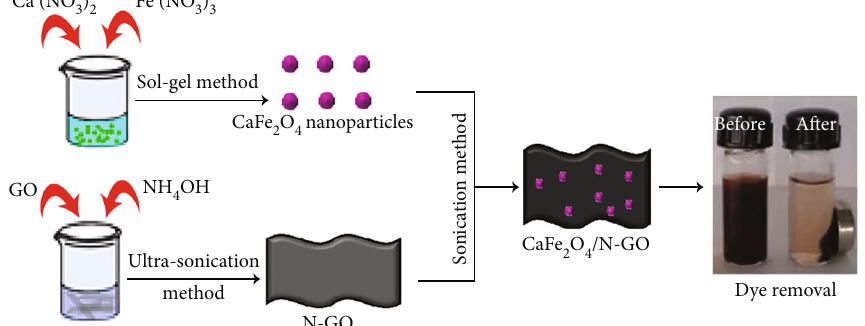
Figure 1: Schematic diagram for the synthesis CaFe